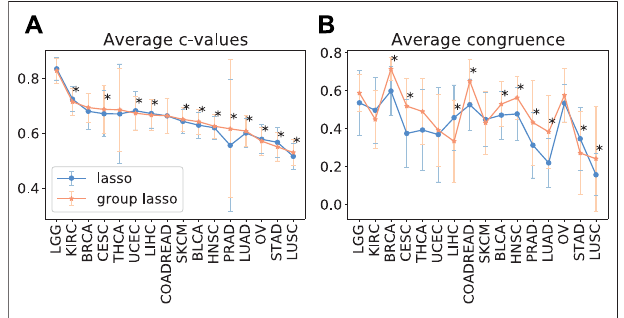
FIGURE 2 | The average test prediction accuracy ( c -value, (A) ) and model stability (average congruence coef fi cients, (B) ) for the standard and group lasso models, evaluated on 16 cancers from the TCGA data set. The error bars represent standard deviations. The asterisks (*) mark signi fi cant p -values at the p < 0.05 level.